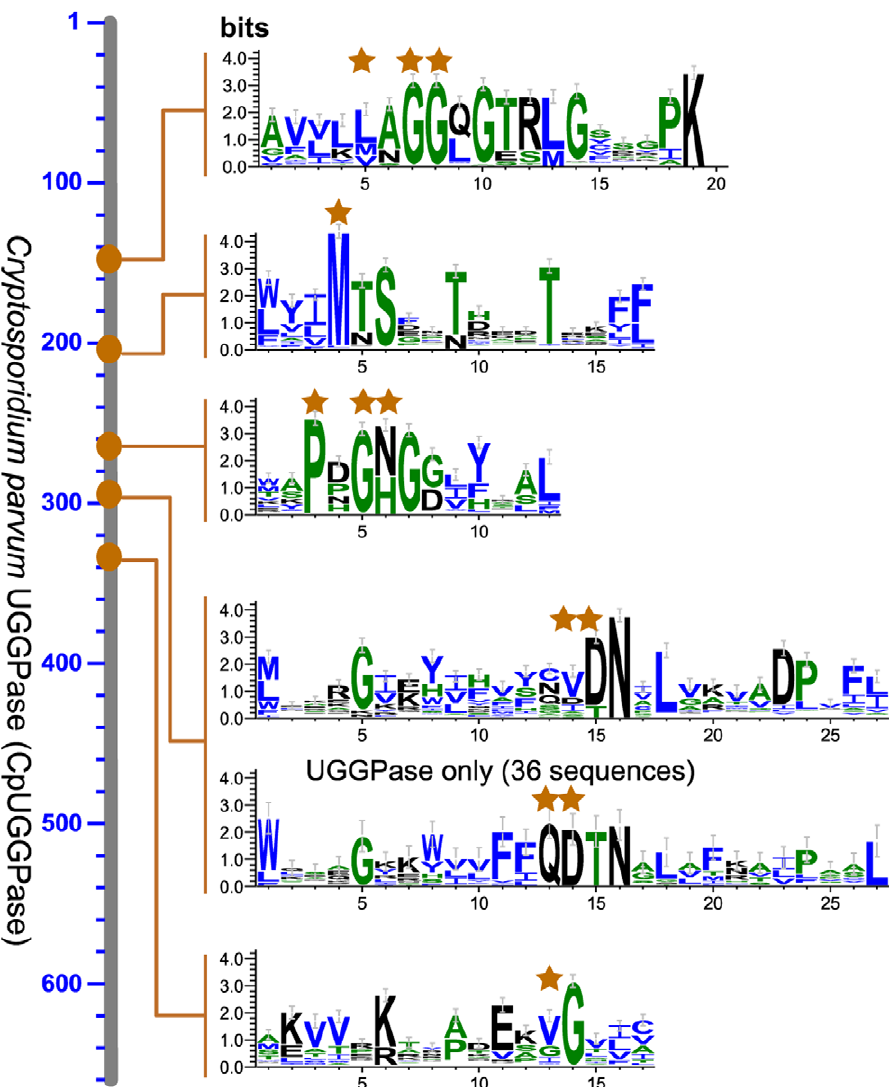
Figure 2. Structure of apicomplexan UDP-glucose/galatose pyrophosphorylase (UGGPase) as exemplified by Cryptosporidium parvum protein (CpUGGPase). Sequence logos represent conserved motifs and domains as determined from 224 sequences of glucosyltransferase family-A (GTA) proteins including UGGPases and UDP- N -acetylglucosamine pyrophosphorylases (UAPs). In the fourth domain, UGGPases displayed a very unique sequence pattern that differs significantly from other GTA proteins. Stars indicate amino acids important at the active sites.